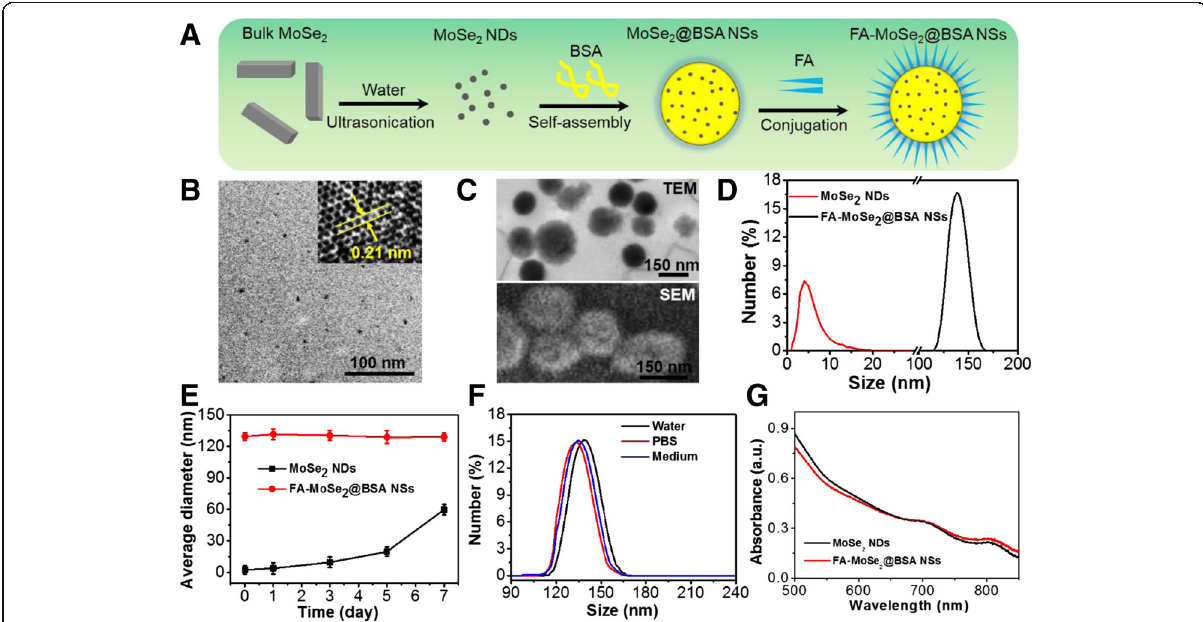
Fig. 1 a A schematic of FA-MoSe 2 @BSA NSs synthesis . b TEM image of MoSe 2 NDs. Inset was the high-resolution TEM image. c The TEM and SEM images of